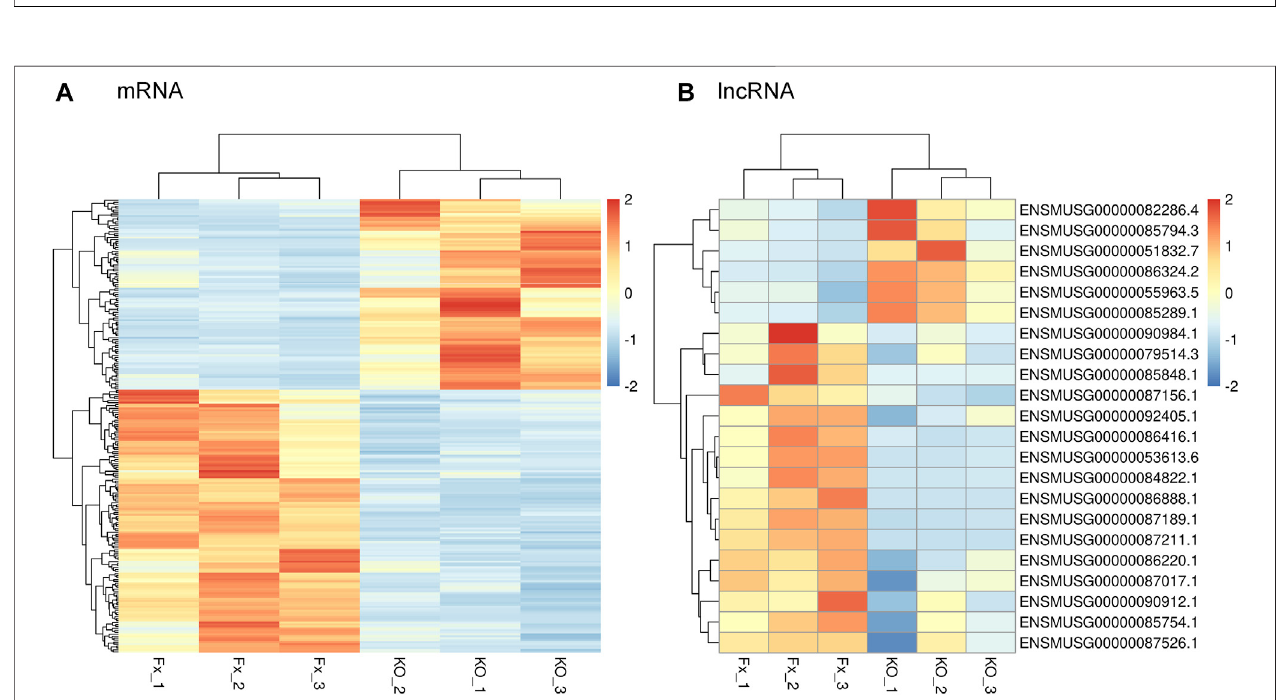
FIGURE 3 | Genetic clustering of differentially expression genes (|log2FC| ≥ 1; Q value < (cid:1) 0.001). (A) mRNAs; (B) and lncRNAs. The red color represents high fold- change, and the blue color represents low fold-change.